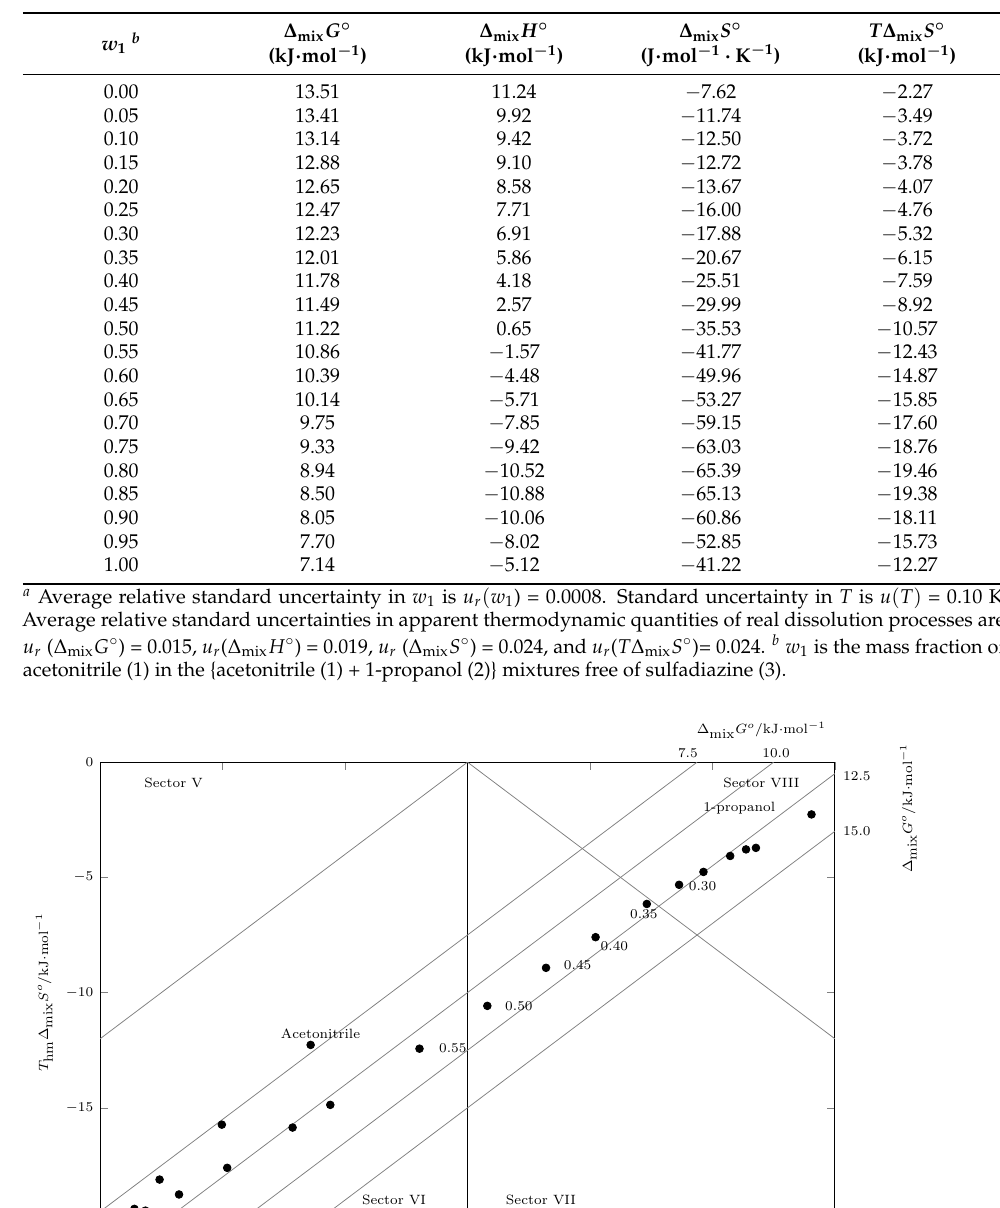
Table 6. Thermodynamic functions relative to mixing processes of sulfadiazine (3) in {acetonitrile (1) + 1-propanol (2)} co-solvent mixtures at T hm = 297.6 K a .